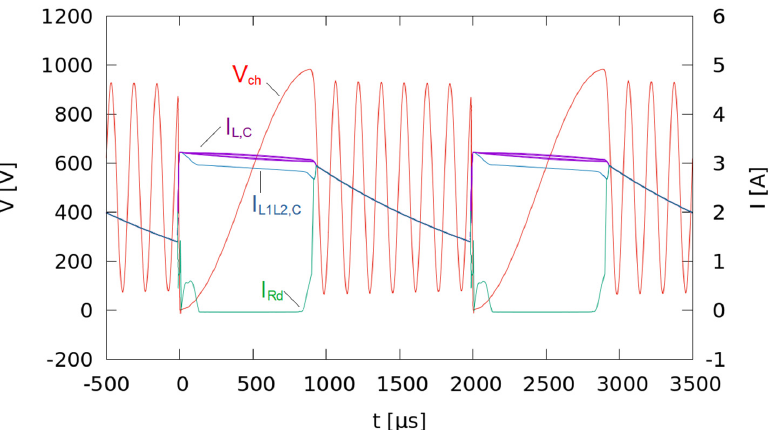
Figure 20. Common mode component of the currents in the current-compensated chokes I L,C in violet colour except for the common mode current component in the leftmost current-compensated choke I L1L2,C , which is shown in blue colour. V ch and I Rd denote the charging voltage at the generator’s input terminal and the current through the damping resistor R D (R3, according to Figure 3),